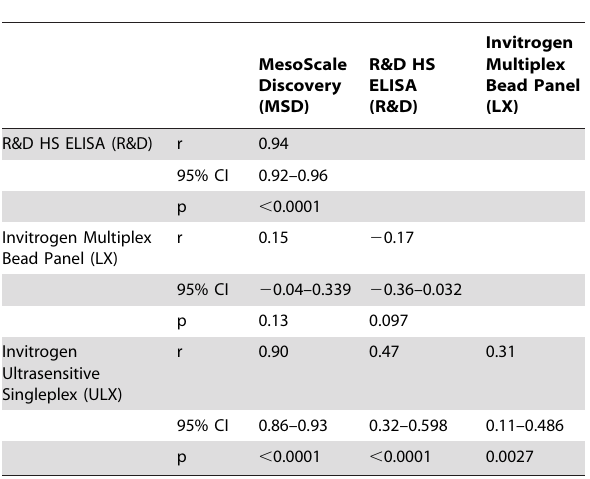
Table 2. Pearson Correlations between four IL-6 assays.